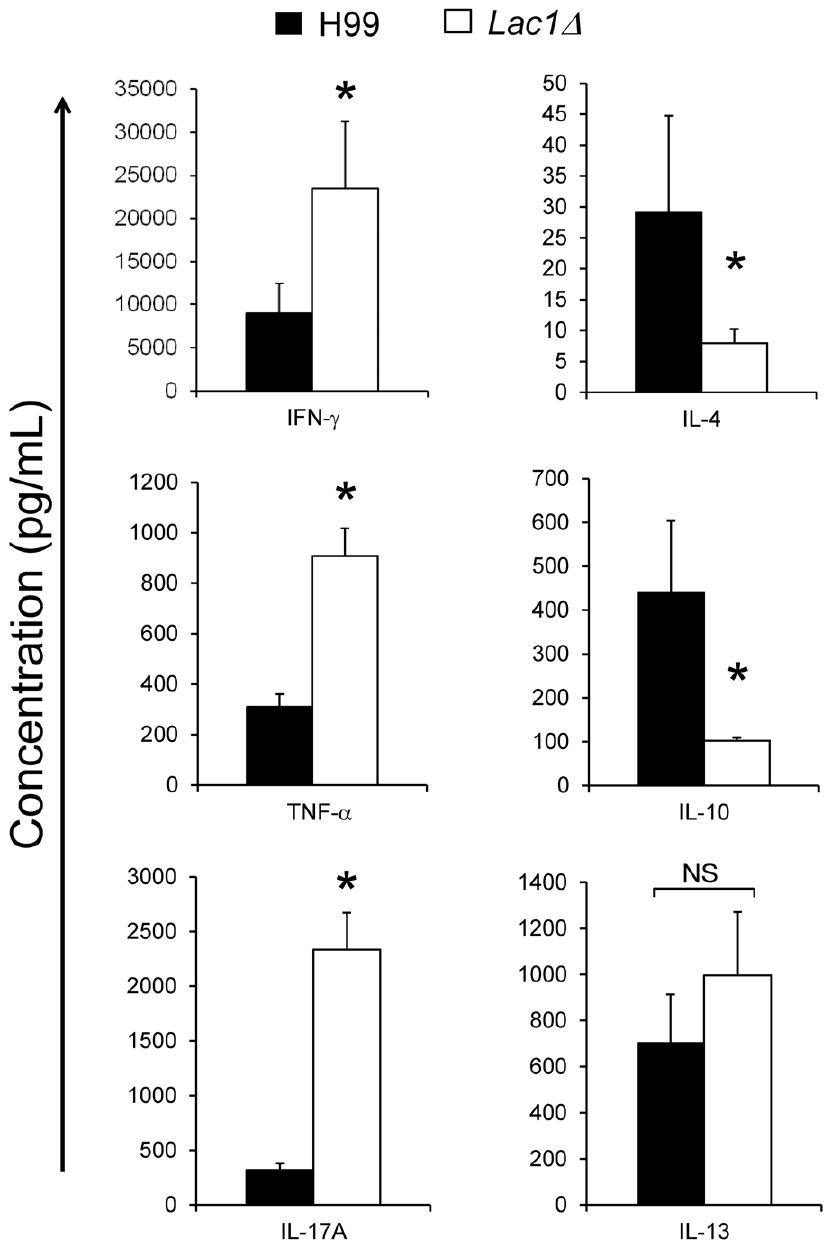
Figure 5. Effect of cryptococcal laccase on lung leukocyte cytokine production. Lung leukocytes were isolated from the lungs of mice infected with C. neoformans strain H99 or lac1 D at 3 wpi and cultured for 24 h at 5 6 10 6 cells/ml. Cytokine levels were evaluated by ELISA in cell culture supernatants. Bars represent mean cytokine concentration 6 SEM (pg/ml). Bars represent mean 6 SEM from 2 separate matched experiments, N =6 and above for each of the analyzed parameters; *p , 0.05 in comparison between wt and mutant; NS, no significant difference between wt and mutant.